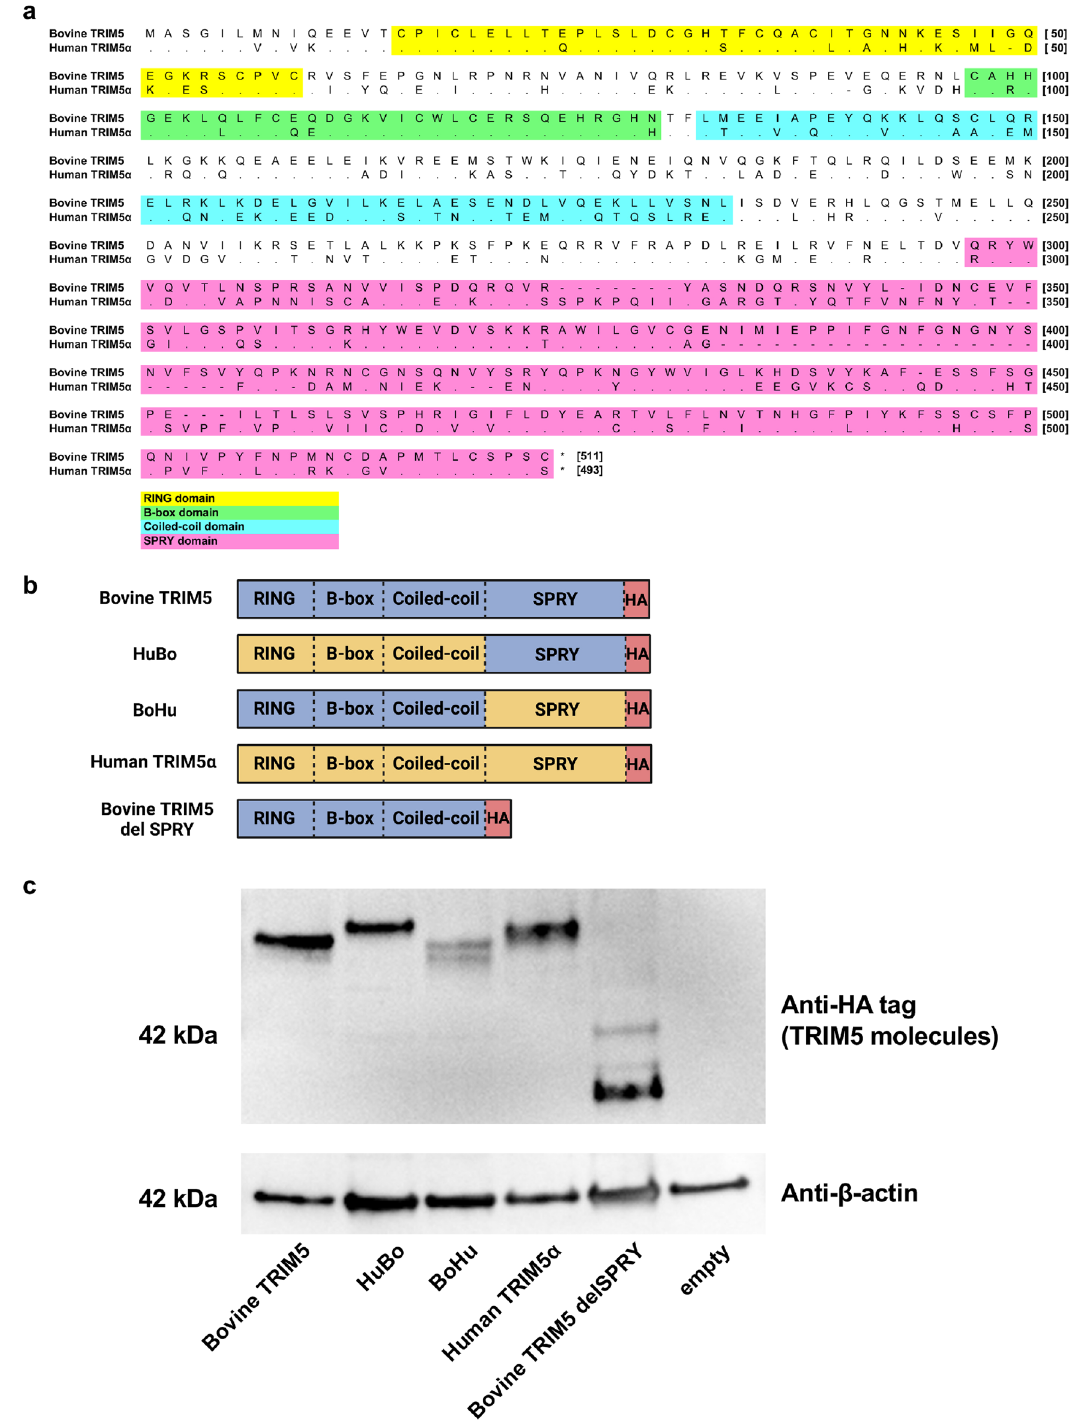
Figure 2. Generation of CRFK cells expressing chimeric TRIM5 proteins. ( a ) Alignment of bovine TRIM5 and human TRIM5α. The protein sequences of bovine TRIM5 and human TRIM5α were aligned using MEGA X. The domains of TRIM5 were indicated in yellow (RING domain), green (B-box domain), blue (Coiled-coil domain), and pink (SPRY domain). ( b ) Schematic representation of chimeric TRIM5 molecules generated in this study. The chimera TRIM5 molecule “HuBo” consists of the RING, B-box, and Coiled-coil (RBCC) domains of human TRIM5α and the SPRY domain of bovine TRIM5. The chimeric TRIM5 molecule “BoHu” consists of the RBCC domain of bovine TRIM5 and SPRY domain of human TRIM5α. A truncated version of bovine TRIM5 lacking the SPRY domain was termed “delSPRY.” ( c ) Expression of each HA-tagged TRIM5 protein in CRFK cells was determined using Western blotting. The cellular lysate of unmodified CRFK cells was used as a negative control